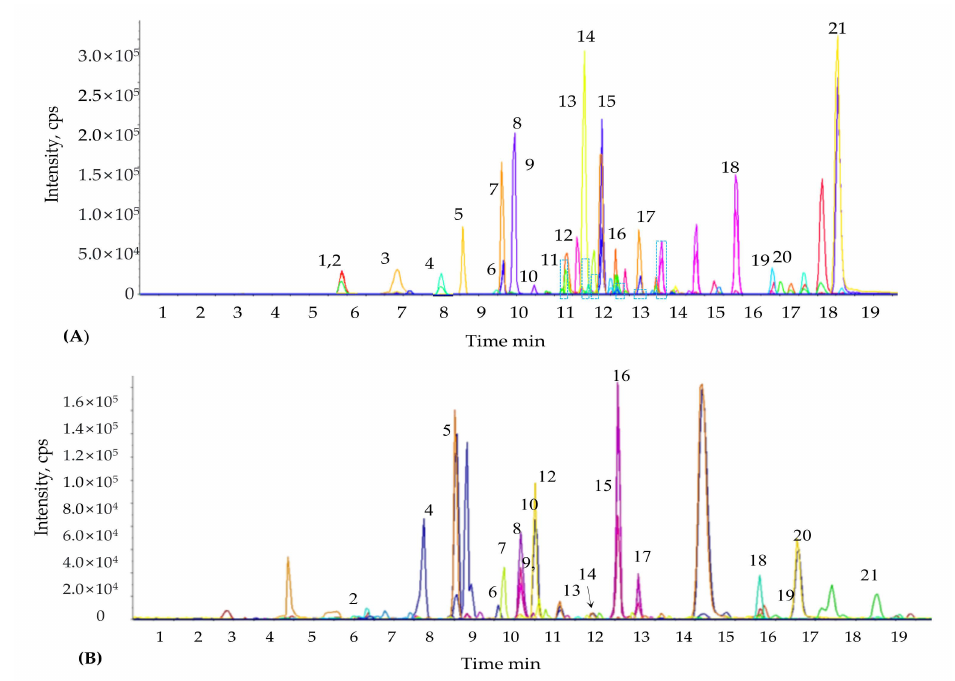
Figure 1. ( A ). Representative multiple reaction monitoring (MRM) ion chromatogram of phenolic compound standards, ( B ) Representative MRM ion chromatogram of phenolic compounds obtained from M. sacchariflorus. 1. L-Phenylalanine; 2, Gallic acid; 3, Homogentisic acid; 4,Protocatechuic